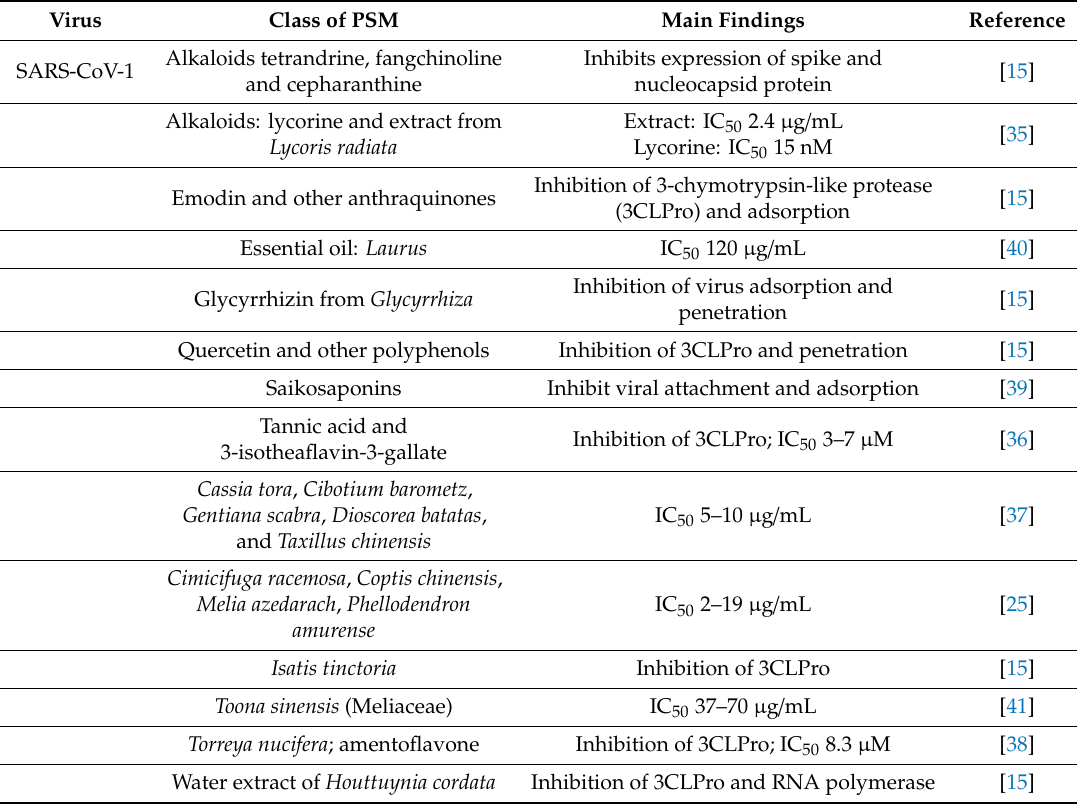
Table 4. Examples of plant extracts active against SARS